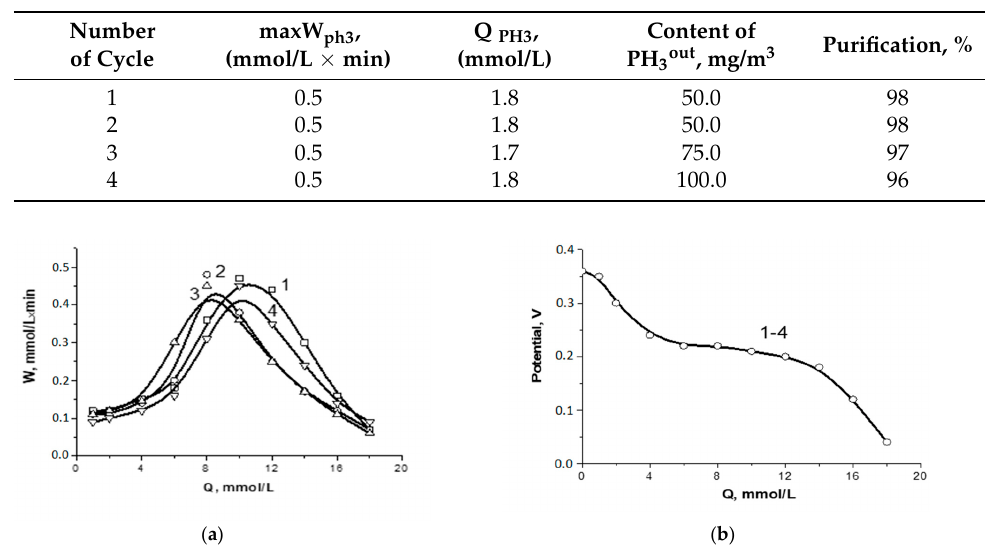
Table 6. Stability of catalyst system of [CuSO 4 ] = 0.4, [NH 4 OH] = 0.65, [H 3 PO 4 ] = 0.95 mol/L at t = 30 ◦ C, C PH3in = 2500 mg/m 3 .